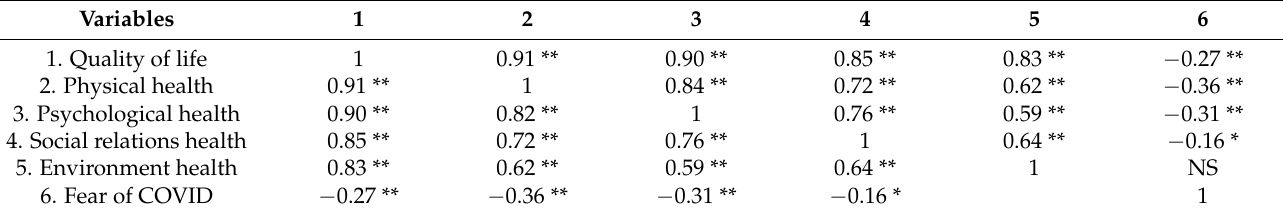
Figure 2. Mean score for the Fear of COVID questionnaire based on the issues reported by the participants. Table 7. The Pearson coefficients of the dependent